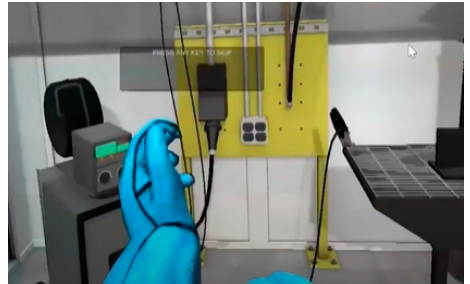
Figure 7. Protective Leather Gloves for Welding.